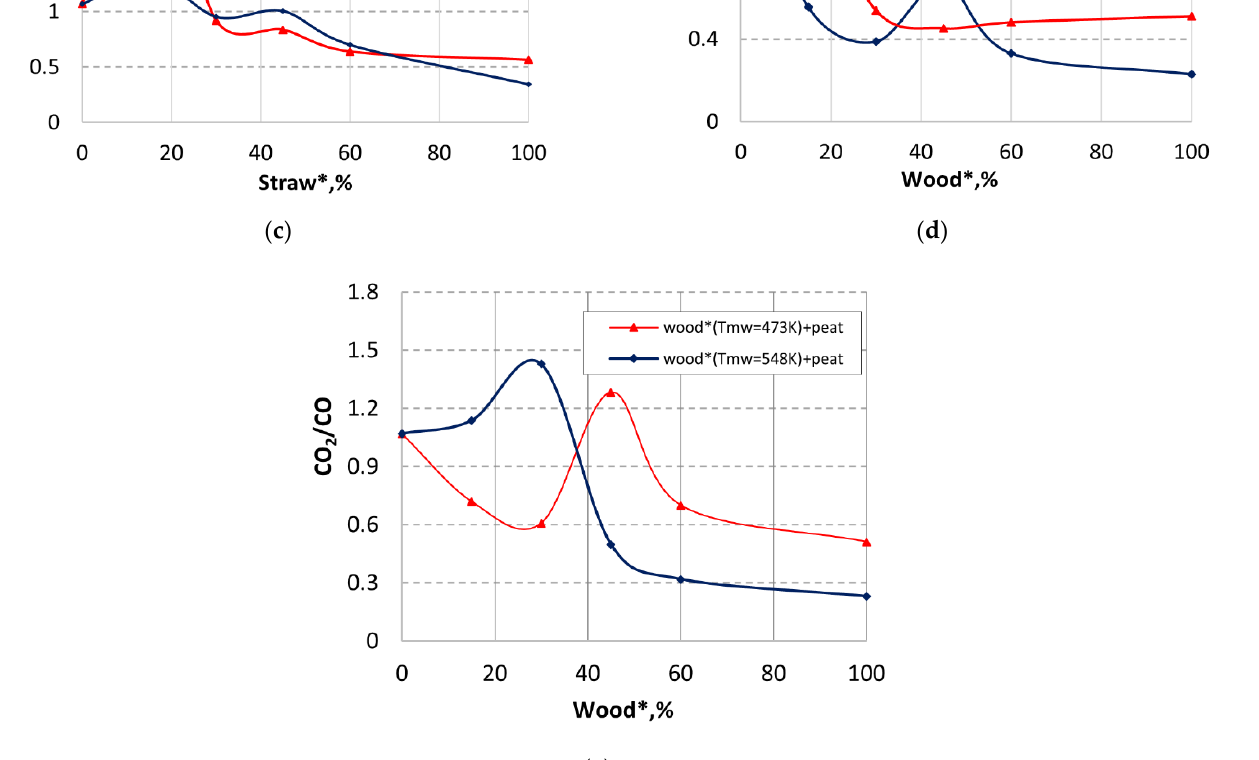
Figure 6. Ratio of CO 2 and CO yields of selected blends ( a – e ) for different MW pre-treatment temperature and mass fraction of pre-treated pellets (for composition of blends see Figure 4).